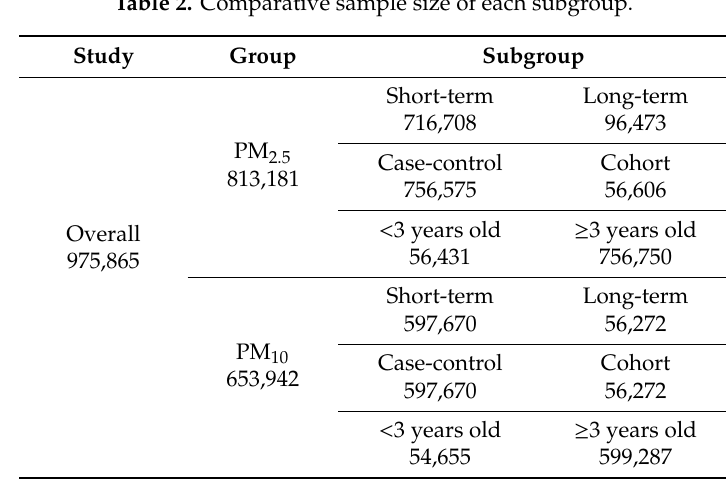
Table 2. Comparative sample size of each